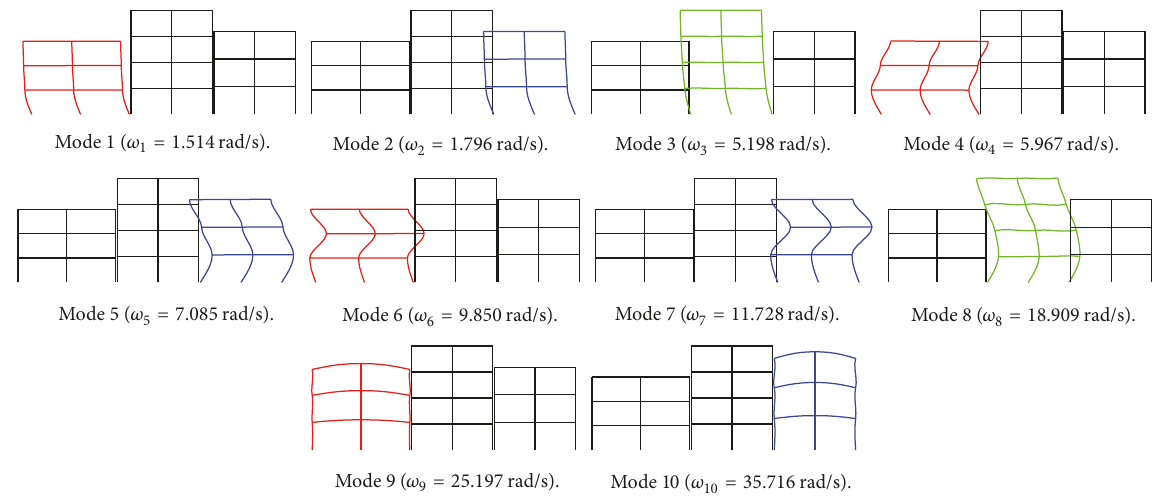
Figure 4: Presentation of the first 10 system